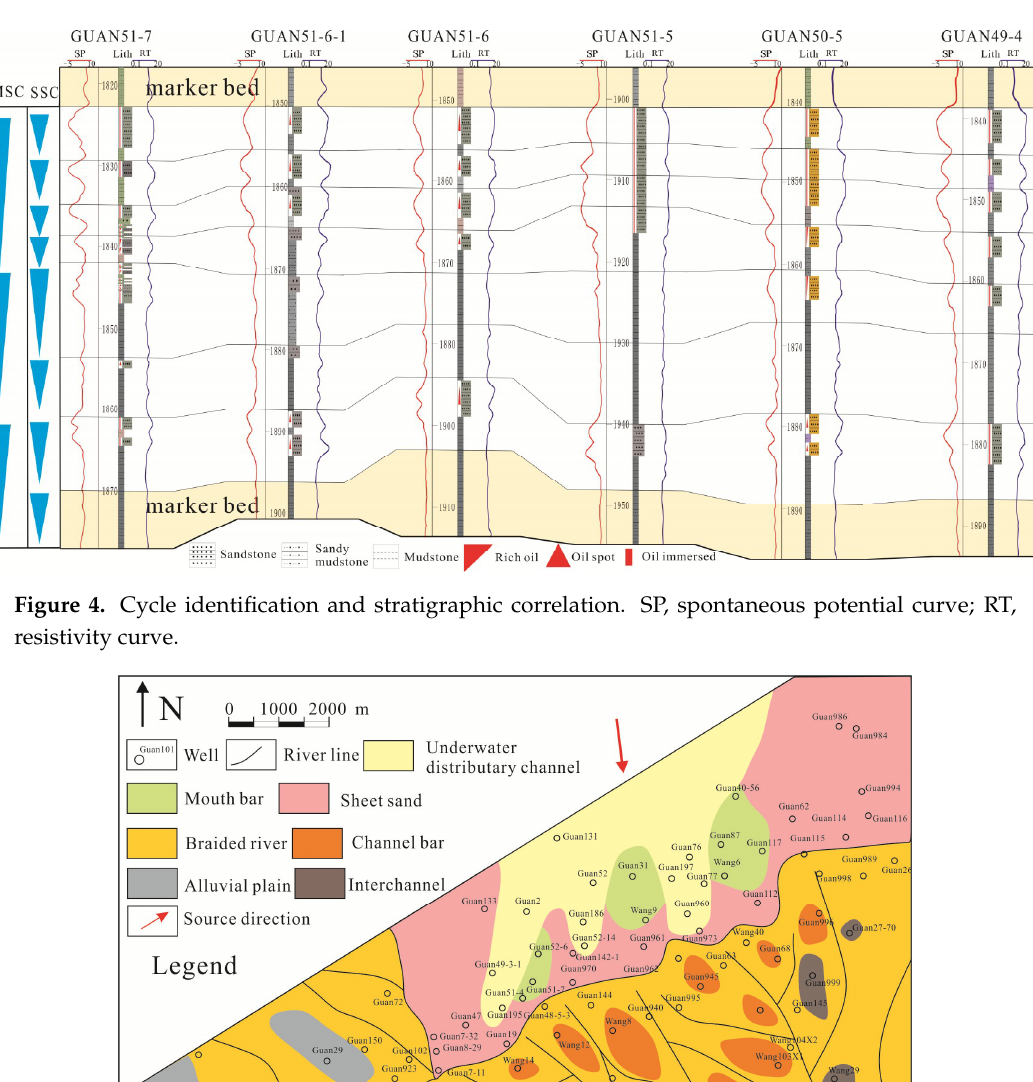
Figure 4. Cycle identification and stratigraphic correlation. SP, spontaneous potential curve; RT, resistivity curve.